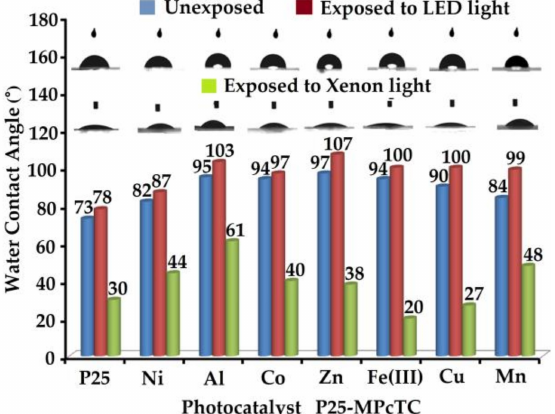
Figure 3. Water contact angle of photocatalytic coatings before and after exposure to LED and Xenon